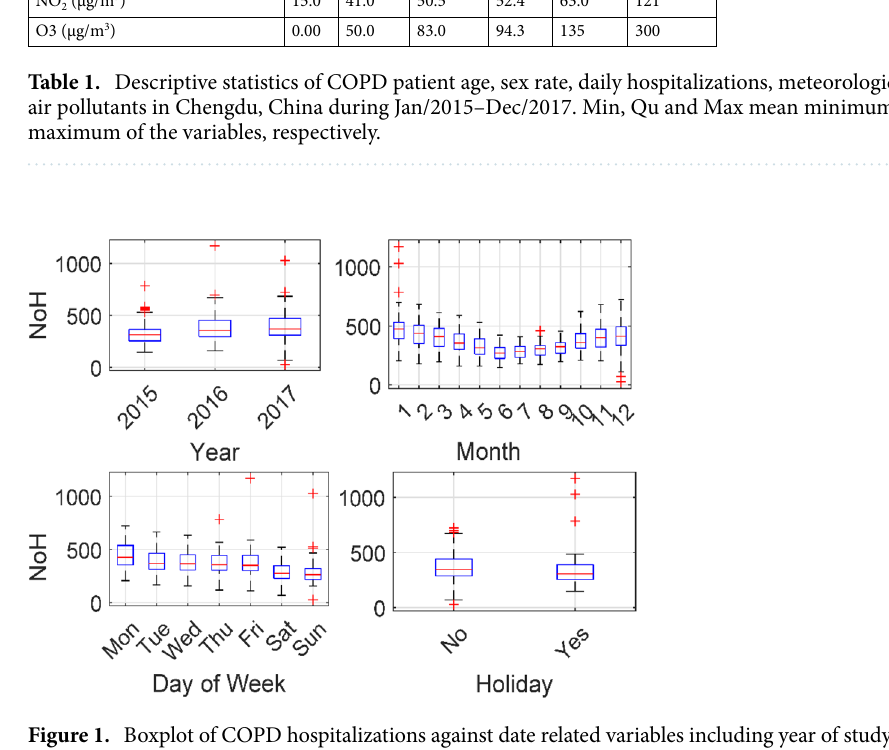
Figure 1. Boxplot of COPD hospitalizations against date related variables including year of study, month, day of week, and